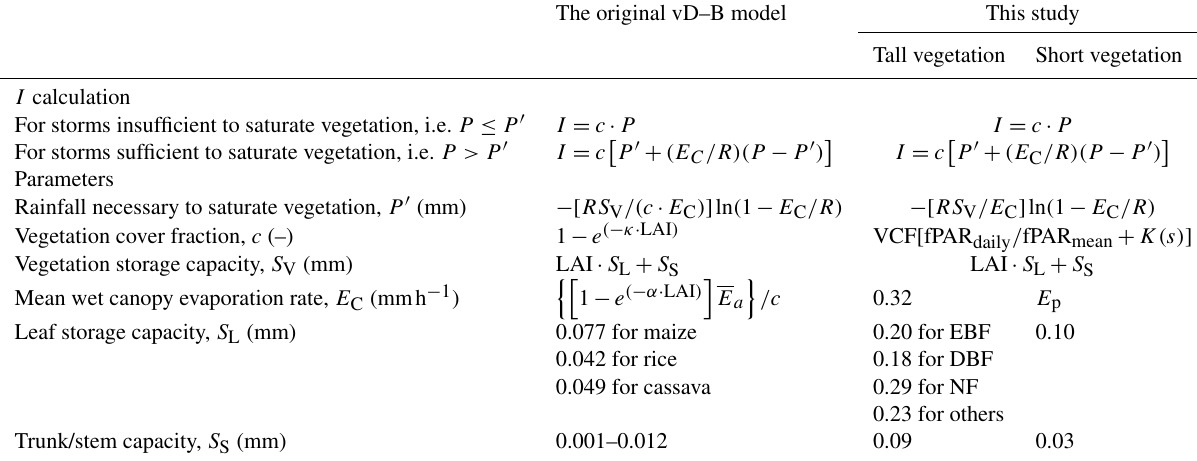
Table 2. Equations and parameters in the original vD–B model and this study. In the original vD–B model, α is the energy exchange coefficient between canopy and atmosphere, and E a is a constant evaporation rate when α approaches infinity. The values of S L and S S in the original vD–B model come from van Dijk and Bruijnzeel (2001a), and the parameterisation in this study is based on the meta-analysis of past field campaigns. EBF, DBF, NF and others represent evergreen broadleaf forest, deciduous broadleaf forest, needleleaf forest and other tall vegetation, separately. The original vD–B model This study Tall vegetation Short